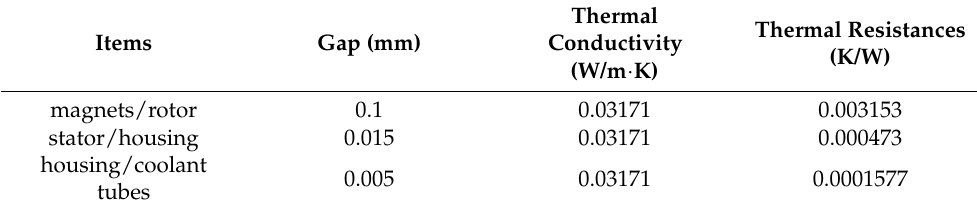
Table 4. Thermal resistances of interfaces between umpteen